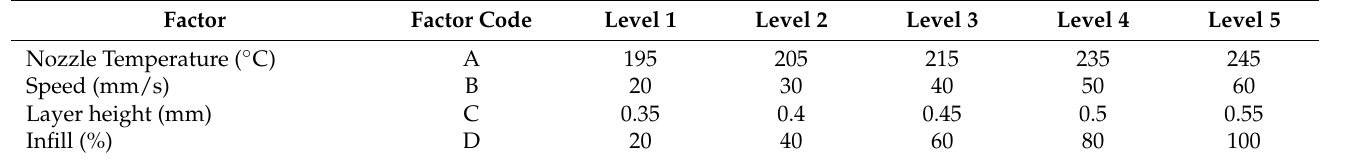
Table 2. Controllable factors and associated levels used in Taguchi experimental design for